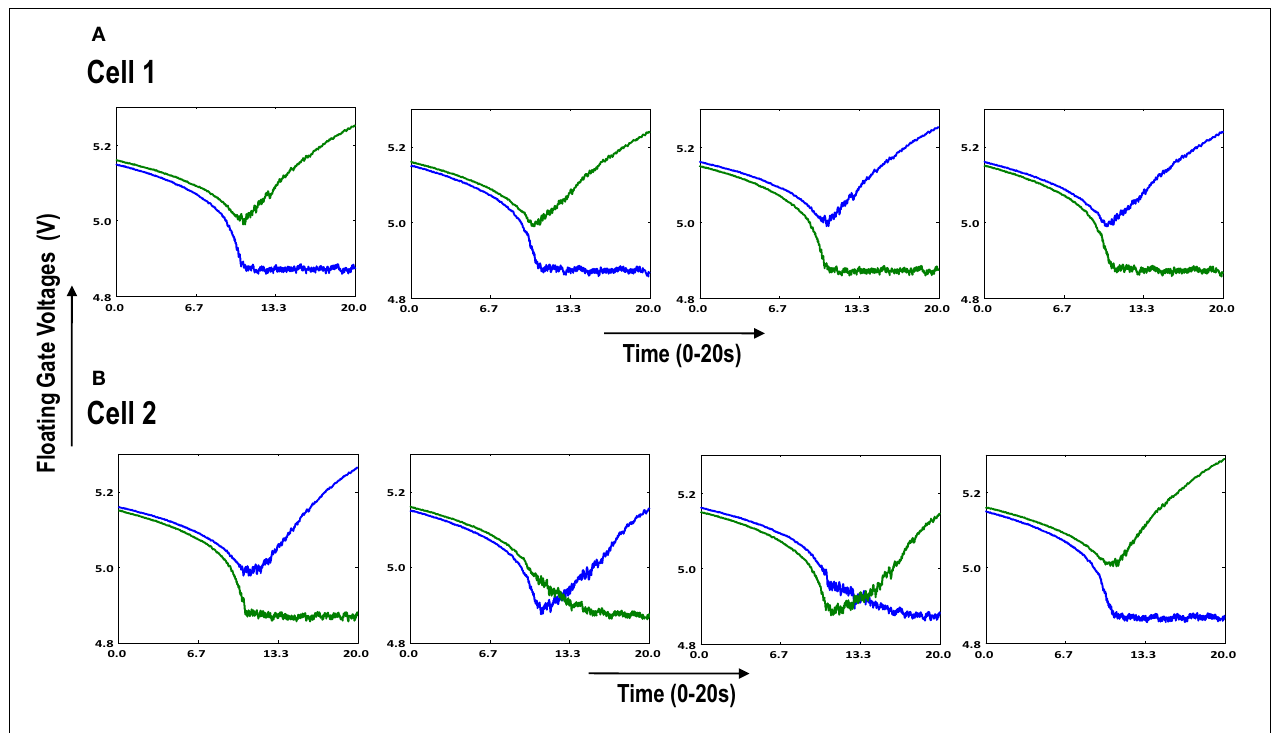
FIGURE 6.2 | Shows the development of floating gate voltages of the two cortical cells of Figure 6.1A. Here blue represents the floating gate voltage of the ON-Centered synapse and green represents the floating gate voltage of the OFF-Centered synapse. The